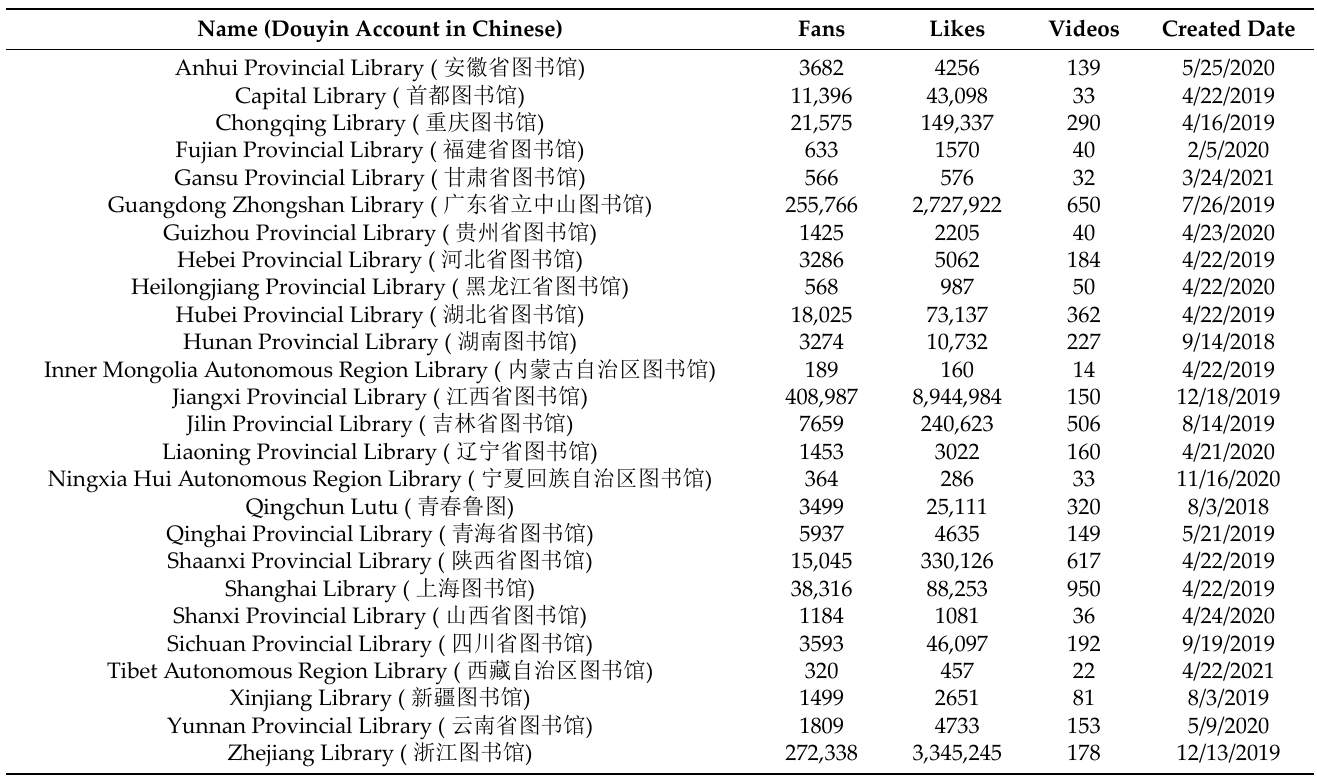
Table 3. General information of Douyin account of 26 public libraries (as of 5 May 2022).